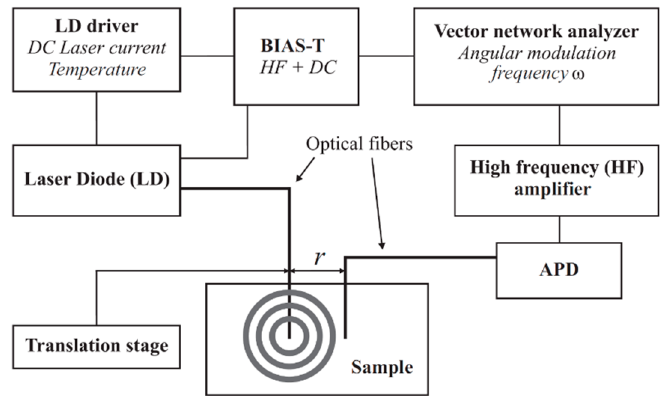
Figure 1. Schematic experimental set-up of a photon density wave (PDW) spectrometer [13].